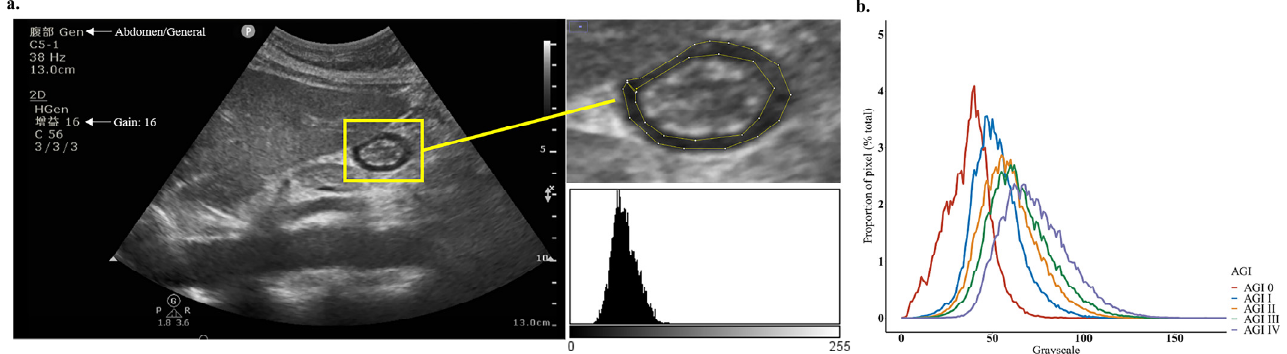
Figure 2. ( a ) The POCUS image of gastric antrum echodensity as processed by the ImageJ with histogram analysis; ( b ) grayscale distribution of varied AGI grades. The grayscale distribution represents the average proportion of pixels (percentage of the total pixels) at each grayscale intensity of gastric antrum echodensity images in varied severities of AGI. POCUS: point-of-care ultrasound, AGI: acute gastrointestinal injury.